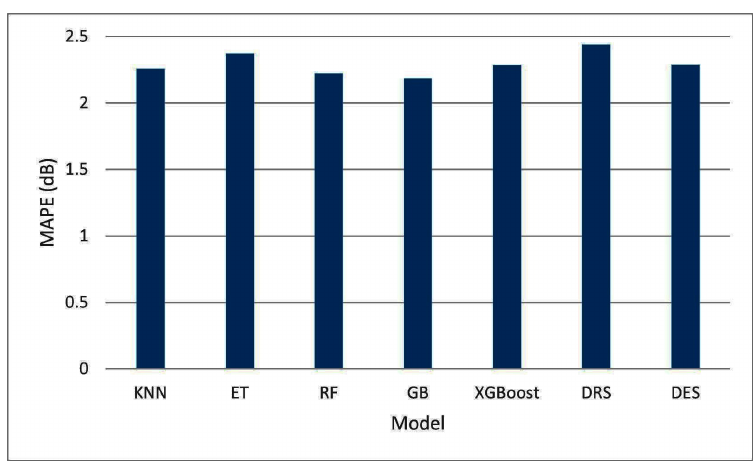
Figure 5. Root Mean Squared Error of models based on dataset 1.